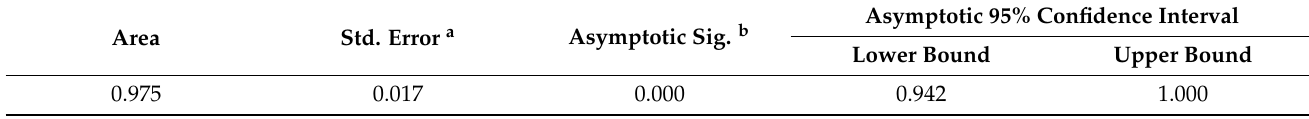
Table 10. Area Under the